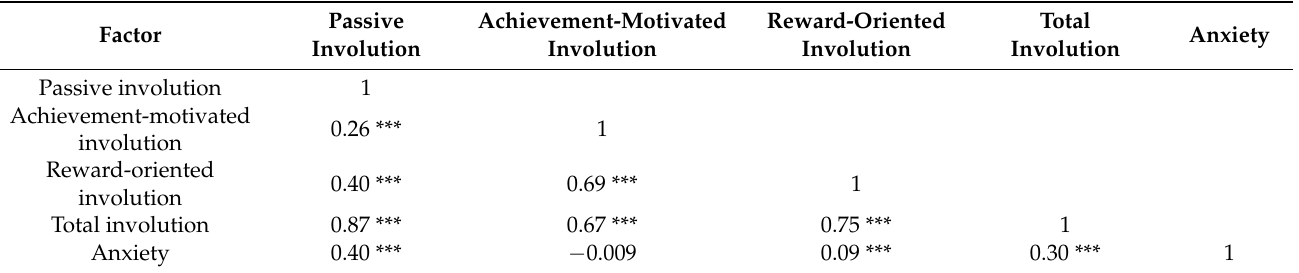
Table 10. Correlations among study variables.